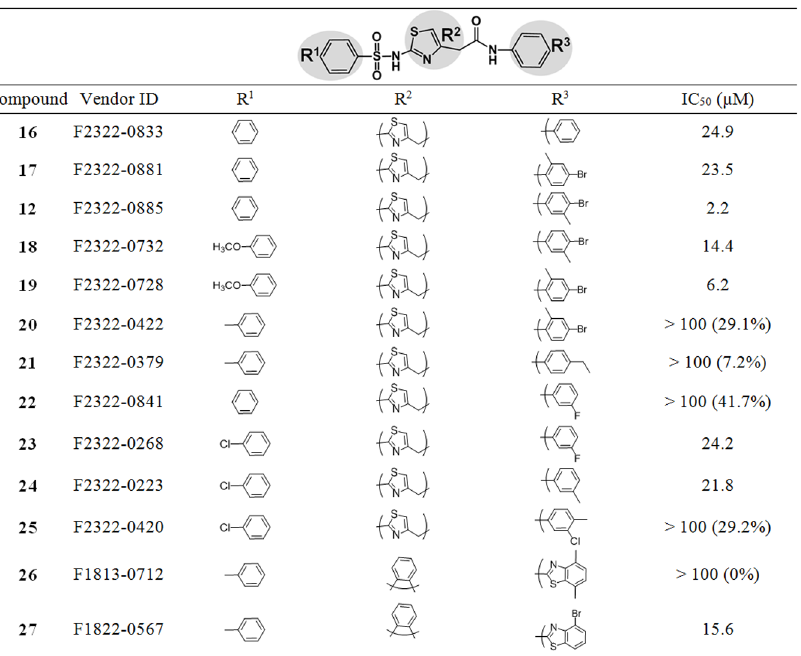
Figure 7. Preliminary Structure and Activity Relationship (SAR) of Compound 12. Out of 25 structurally similar Life Chemicals compounds and 28 additional compounds from a scaffold search based on 12 , % inhibition and IC 50 values of 13 compounds are shown for comparison. IC 50 values were determined from two to four independent assays. The percent inhibitions of each compound are shown in parenthesis in cases of IC 50 value above 100 m M at 50 m M compound concentration.